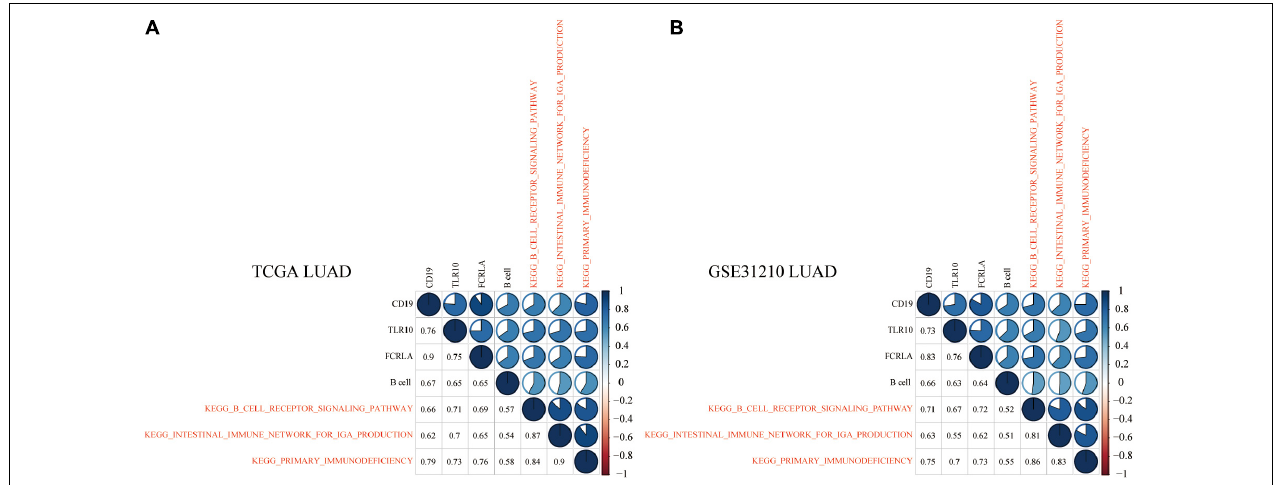
FIGURE 12 | In LUAD tissues of TCGA (A) and GSE31210 (B) , the above three shared KEGG pathways were highly related to B cell and CD19, TLR10, and FCRLA and are marked in